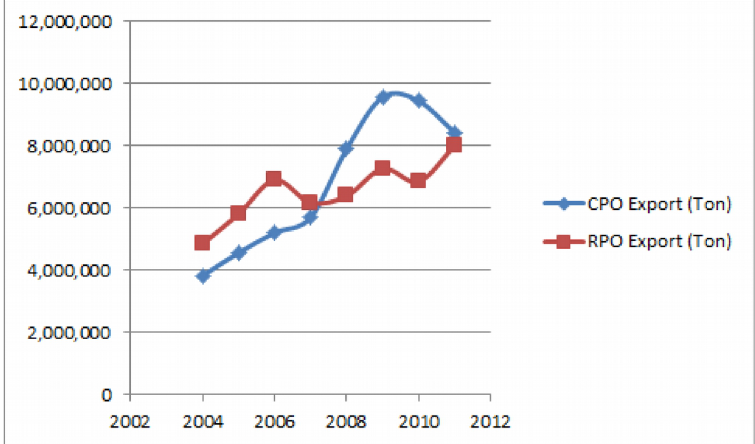
Figure 4. Indonesian CPO and RPO exports during 2004-2011